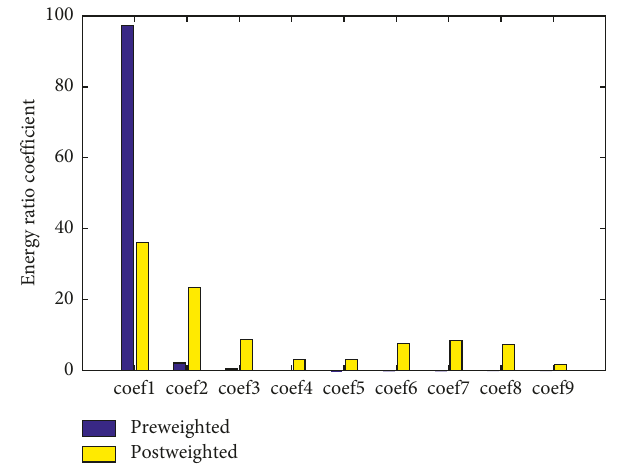
Figure 6: Comparison of the 9 orders component energy ratio of sample S 1.